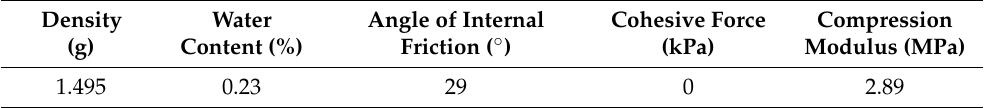
Table 1. Physical and mechanical indices of dry